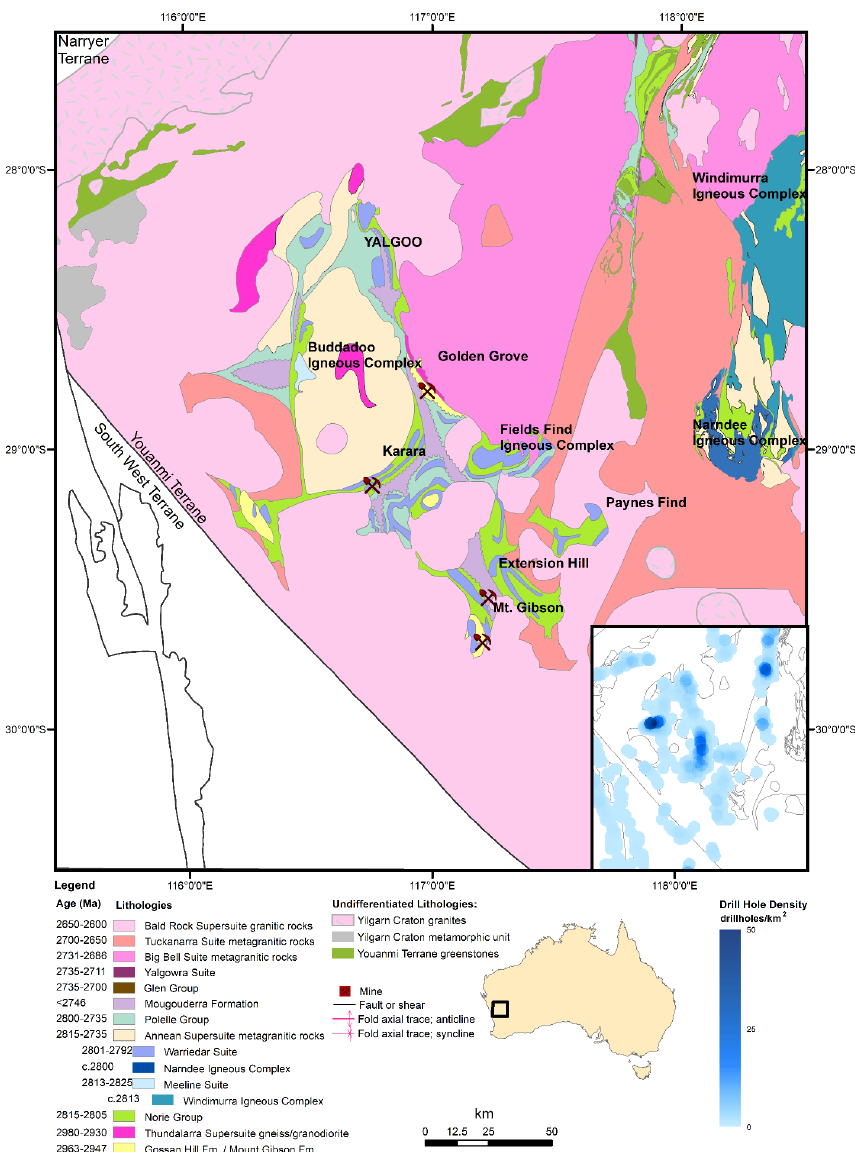
Figure 4. The map shows the Yalgoo–Singleton greenstone belt highlighting the different mines and prospects in the area. The inset map shows the heterogeneous distribution and drill hole density from the legacy data available from the WAMEX database.